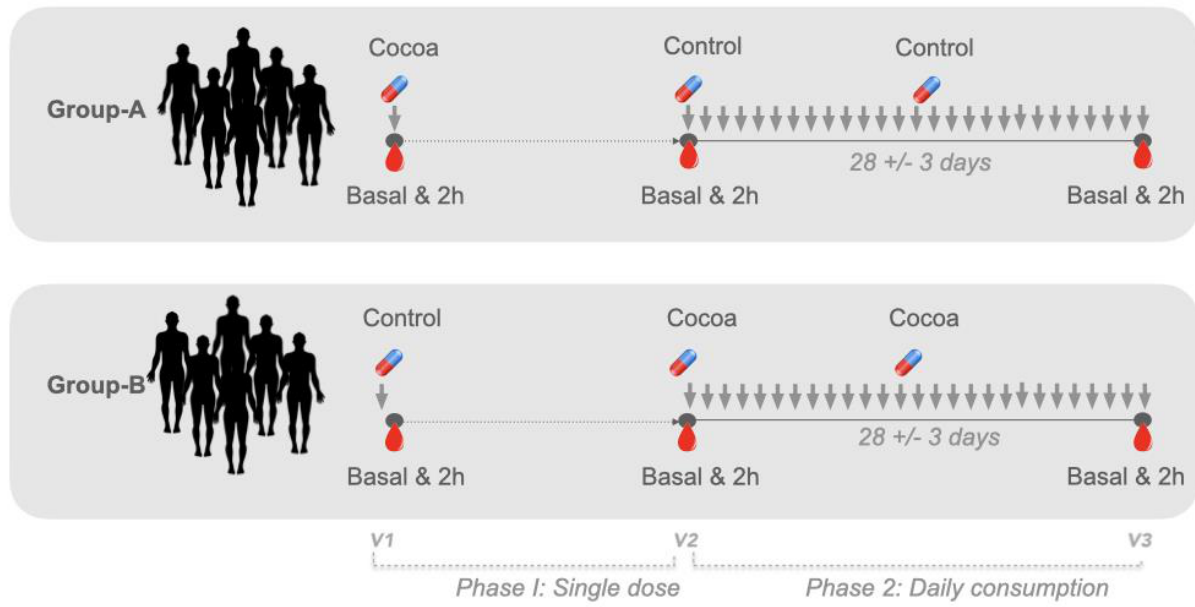
Figure 1. Study design. The study design was a double-blinded, randomized, crossover clinical trial for the evaluation of single-dose intake in healthy young adults ( n = 10 per group) and followed by a controlled parallel-design for evaluation of sustained consumption consisting of daily doses of 1.3 g of the product for 28 ± 3 days (control n = 9 and cocoa n = 10).